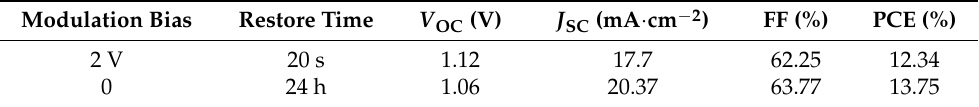
Table 3. Photovoltaic parameters of electric field modulated quasi-2D perovskite solar cells placed in the glove box with a pure nitrogen environment after electric field modulation for 1min and 24 h with the same batch of devices.